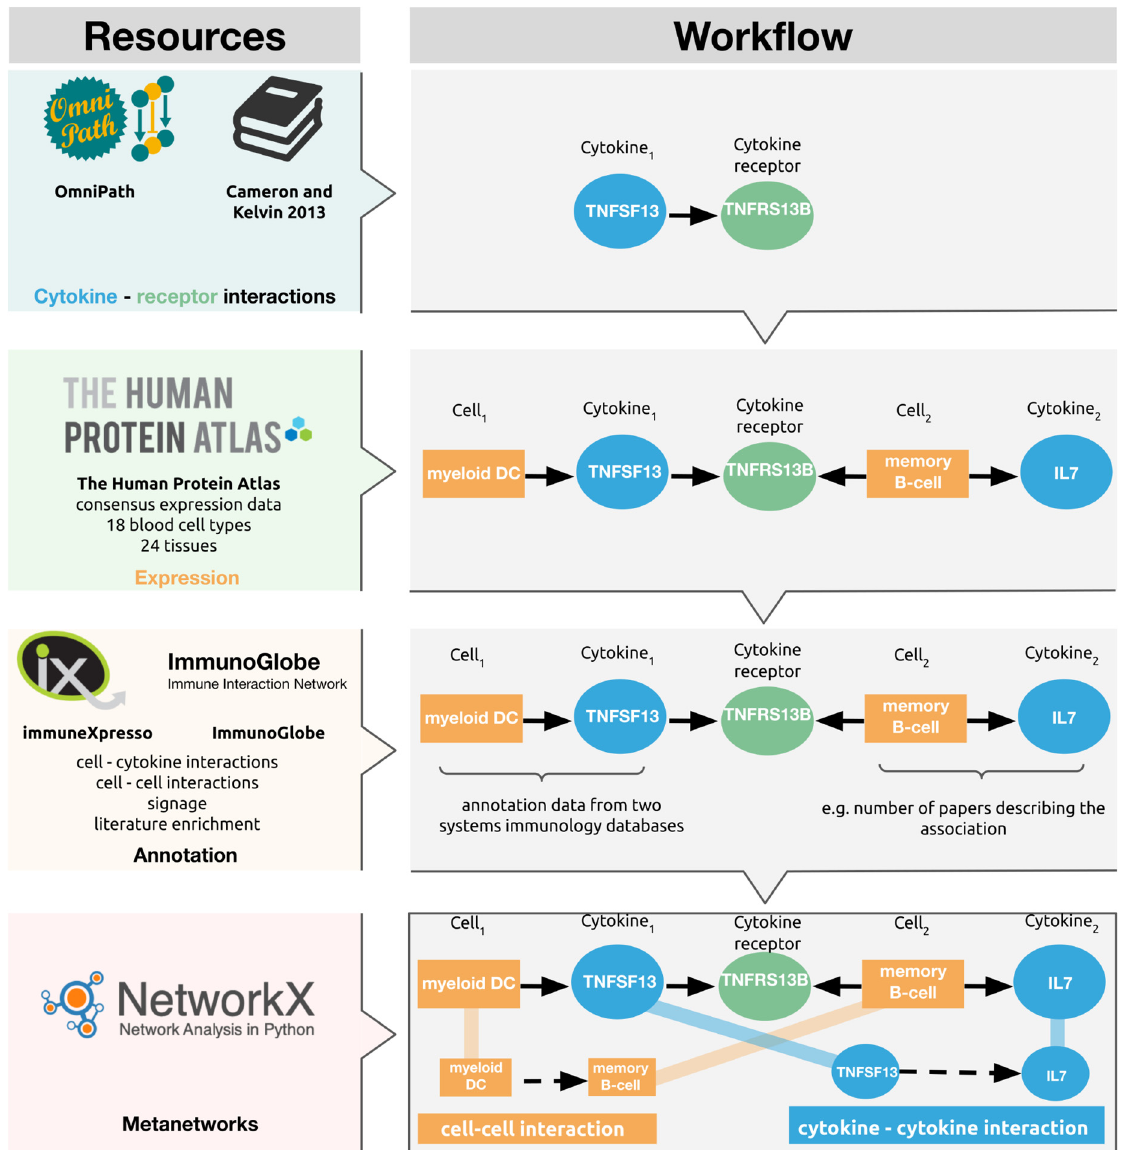
Figure 1. The construction steps and main sources of CytokineLink. Cytokine–receptor data was obtained from OmniPath and a relevant literature source. RNA enrichment data was downloaded from the Human Protein Atlas to assign cytokines and cytokine receptors to source tissue and cell types. The combination of cytokine–receptor interactions, and tissue/cell–cytokine/receptor interactions was used to generate base networks containing tissue–cytokine–receptor interactions, from which abstracted meta-edges were created. The cell–cytokine associations were further annotated using information from two systems of immunology databases, immuneXpresso and ImmunoGlobe. The cell–cell meta-edges show the intercellular interactions mediated by the individual cytokines. The cytokine–cytokine edges indicate the potential ways by which the production of a cytokine can alter the production of another, by binding to its receptor carried by a cell type expressing the secondary cytokine.